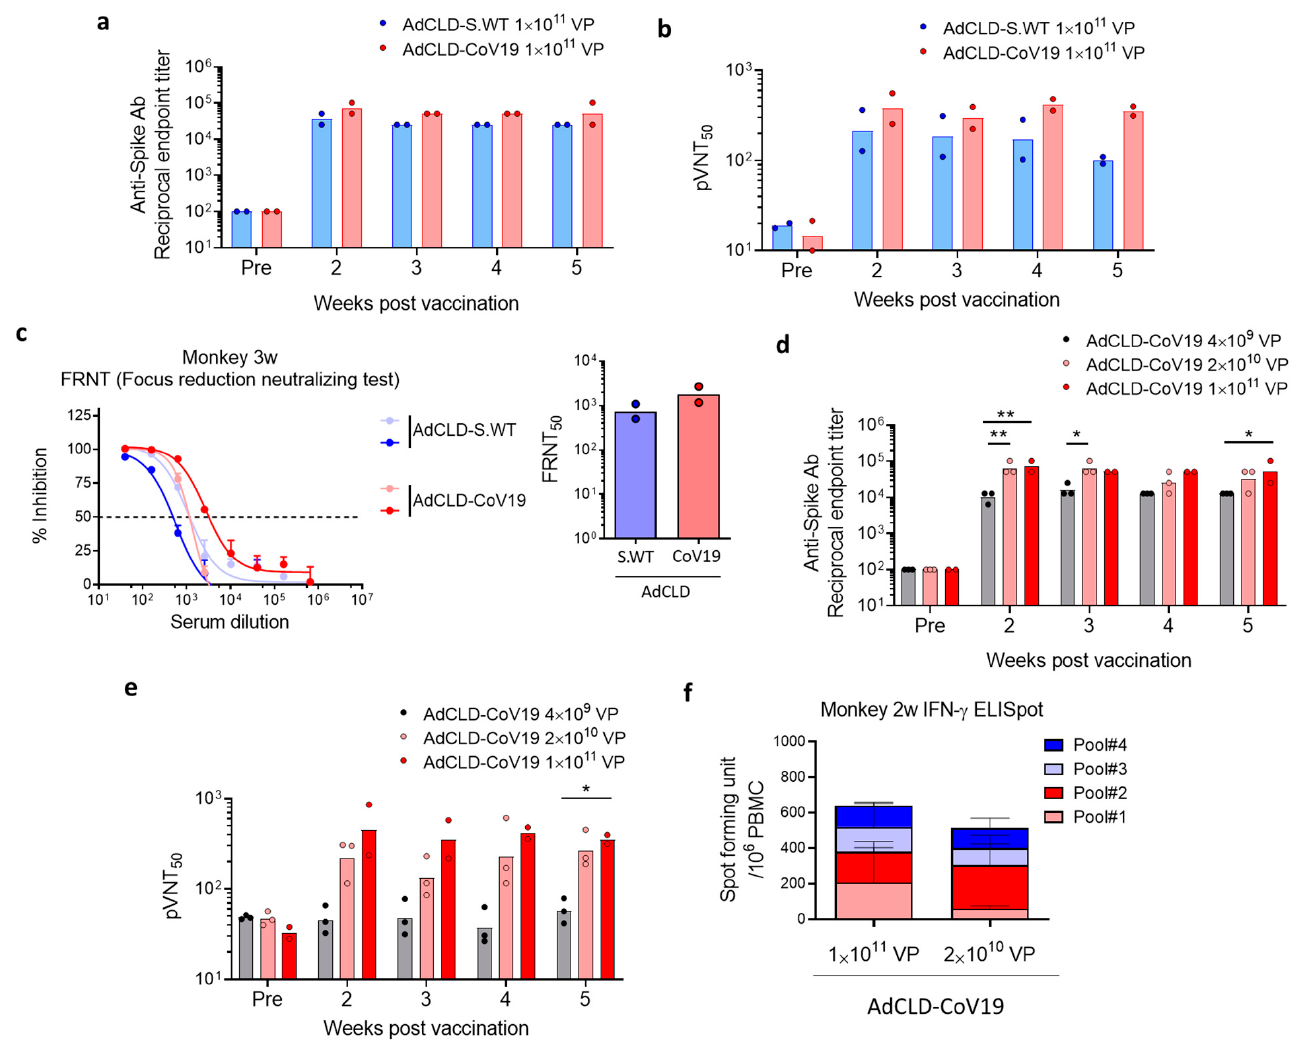
Figure 3. Immunogenicity of AdCLD-CoV19 in macaques. ( a – c ) Naïve cynomolgus macaques received 1 × 10 11 VP of AdCLD-CoV19 or AdCLD-S.WT with a single intramuscular injection and serums were collected at indicated time points. Serums were assessed for S-specific Abs by ELISA ( a ) and neutralizing Abs by SARS-CoV-2 pseudovirus neutralization test, pVNT50, 50% pseudovirus neutralization titer ( b ). ( c ) Focus-reduction neutralizing tests (FRNT) were conducted using serum samples collected 3 weeks post-vaccination. ( d – f ) Cynomolgus macaques were vaccinated with 1 × 10 11 VP or 2 × 10 10 VP of AdCLD-CoV19, and their immunogenicity was accessed at the indicated time points. ( d ) S-specific Ab ELISA, ( e ) pseudovirus neutralization assay, and ( f ) IFN- γ ELISpot assay. Two-tailed Student’s t -test ( a – c , e ) and one-way analysis of variance with Tukey’s multiple comparison (ANOVA) ( d , e ) were used for the analysis. *, p < 0.05; **, p <